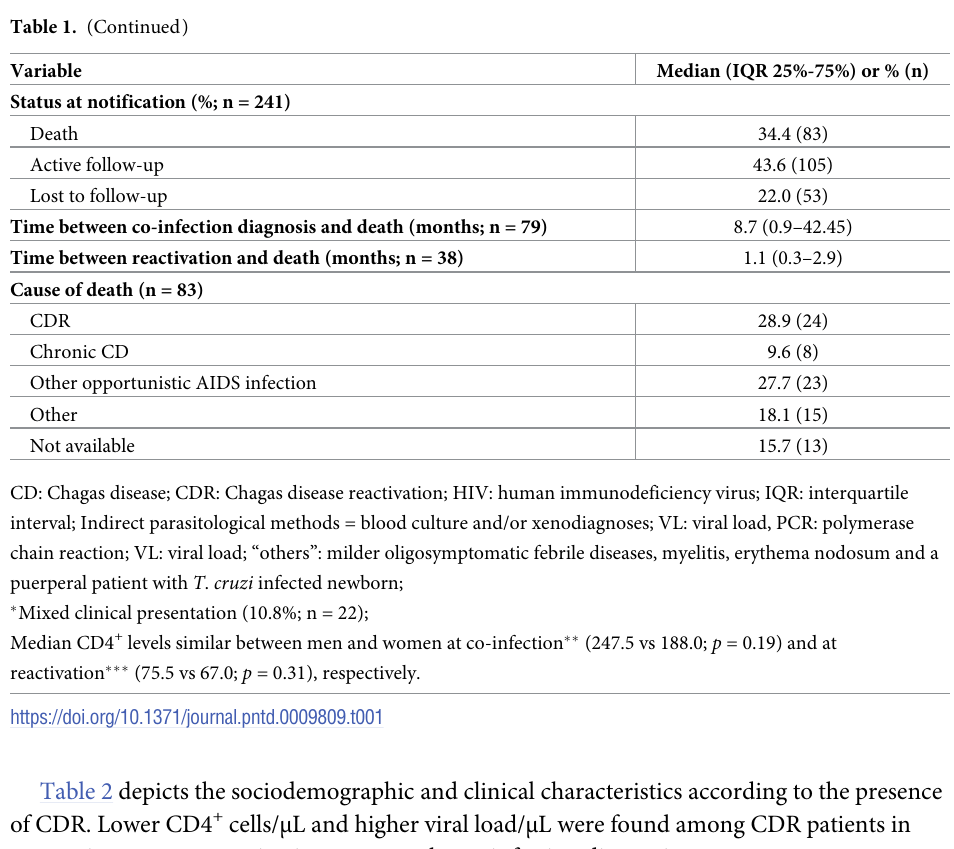
Table 2 depicts the sociodemographic and clinical characteristics according to the presence of CDR. Lower CD4 + cells/ μ L and higher viral load/ μ L were found among CDR patients